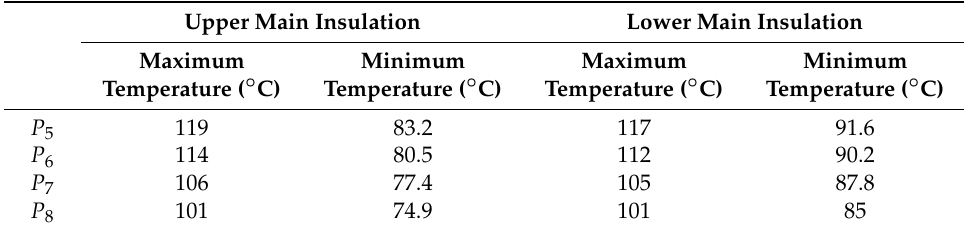
Table 4. The maximum and minimum temperature on P 5 – P 8.